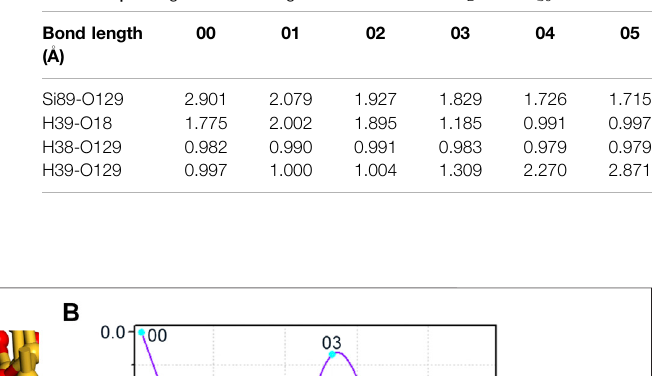
TABLE 2 | Changes in bond length for the reaction of H 2 O and P b0